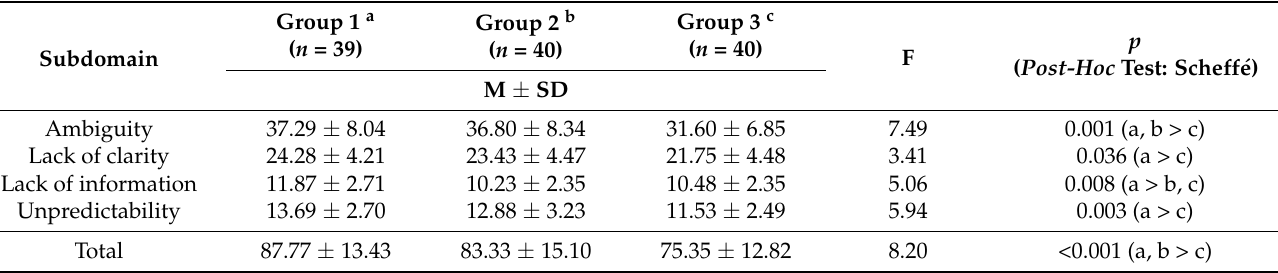
Table 3. Uncertainty score according to treatment phases in each group ( n =